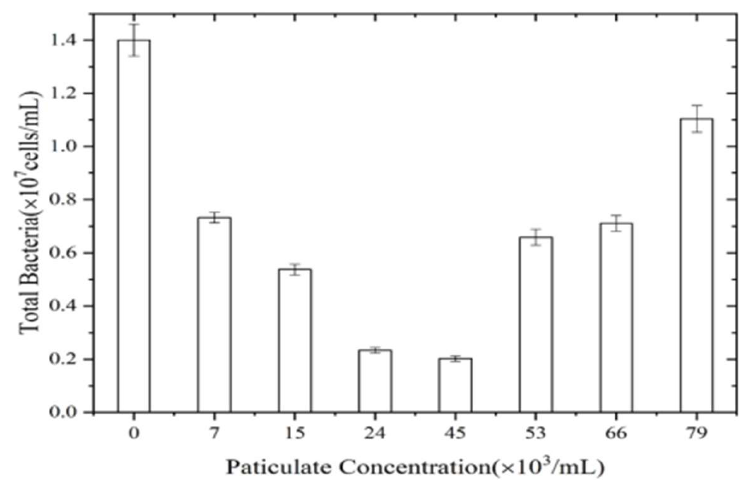
Figure 3. Impact of particle concentration on microbial biofilm formation.